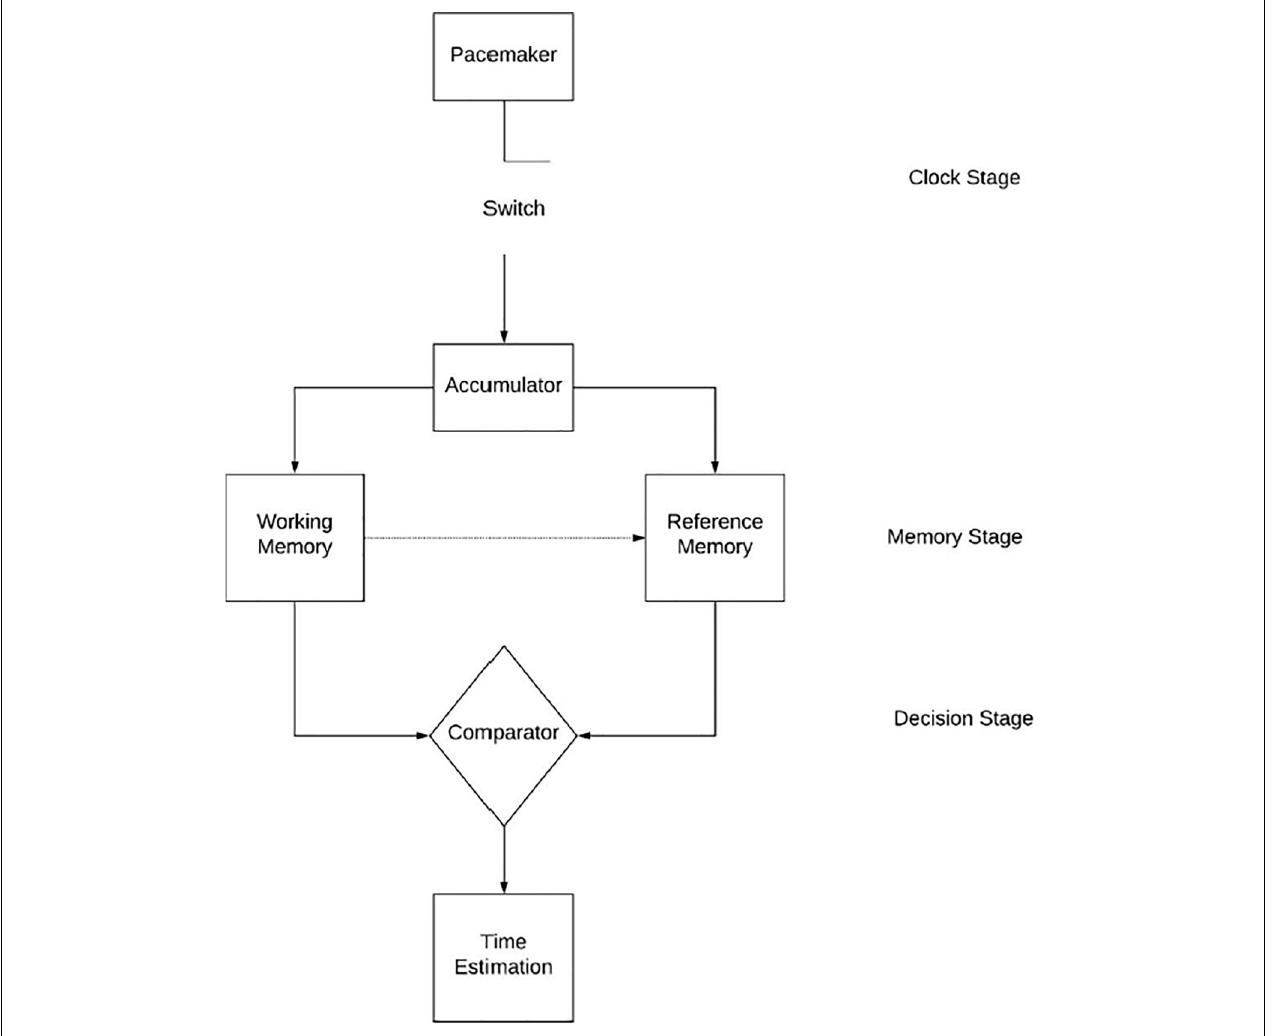
FIGURE 1 | The processing of information inside of the hypothesized internal clock as it relates to time perception as described by the scalar expectancy